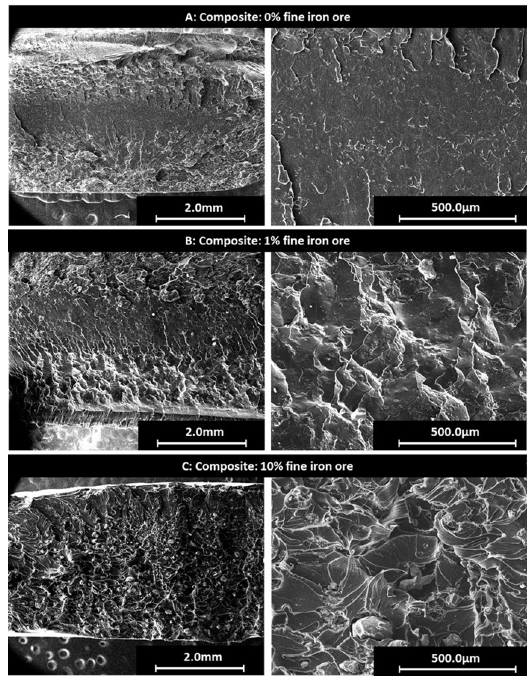
Figure 10. SEM images of fractured surfaces of neat UHMWPE and their compounds with iron ore fine in two magnifications after 33 days of UV